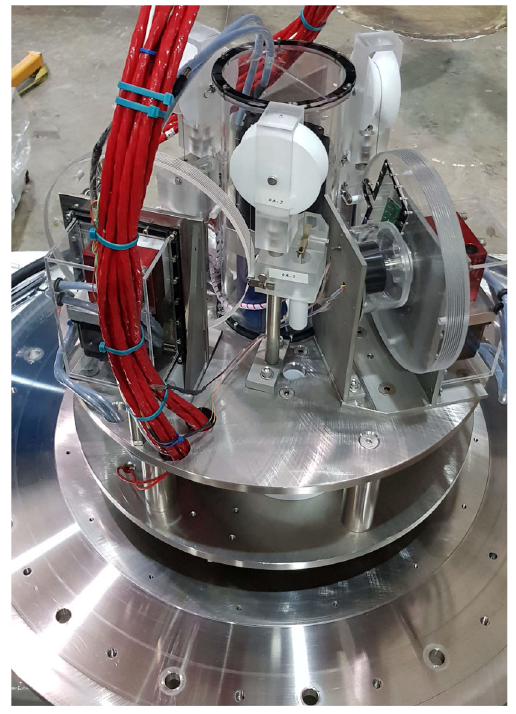
Fig. 11 The automated calibration system (ACU) with the bell jar removed. Three acrylic winches are mounted to a turntable, allowing to lower sources down into the detector through a 1-in. hole in the bottom